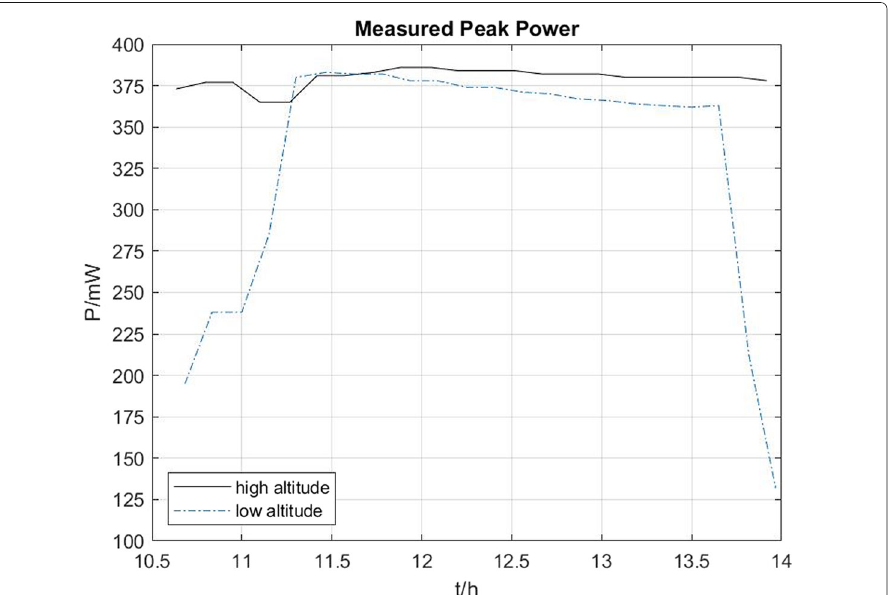
Fig. 7 Maximum power over